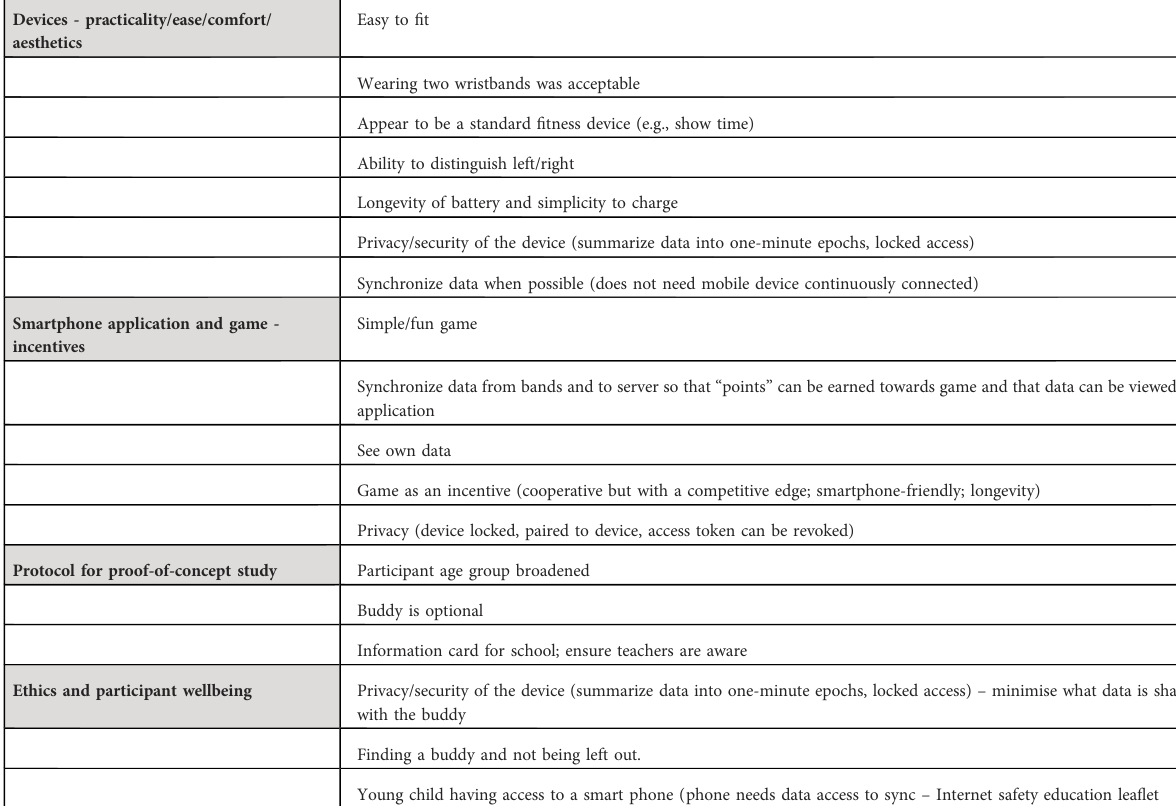
TABLE 2 Summary of design principles. Devices - practicality/ease/comfort/ aesthetics